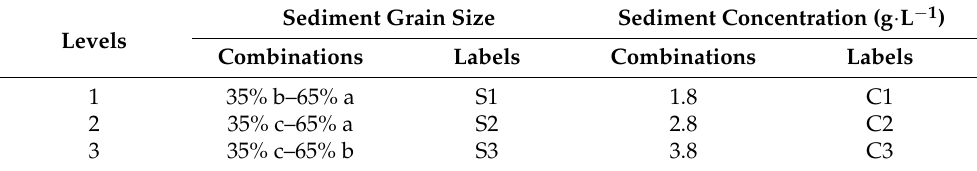
Table 2. Levels and factors.